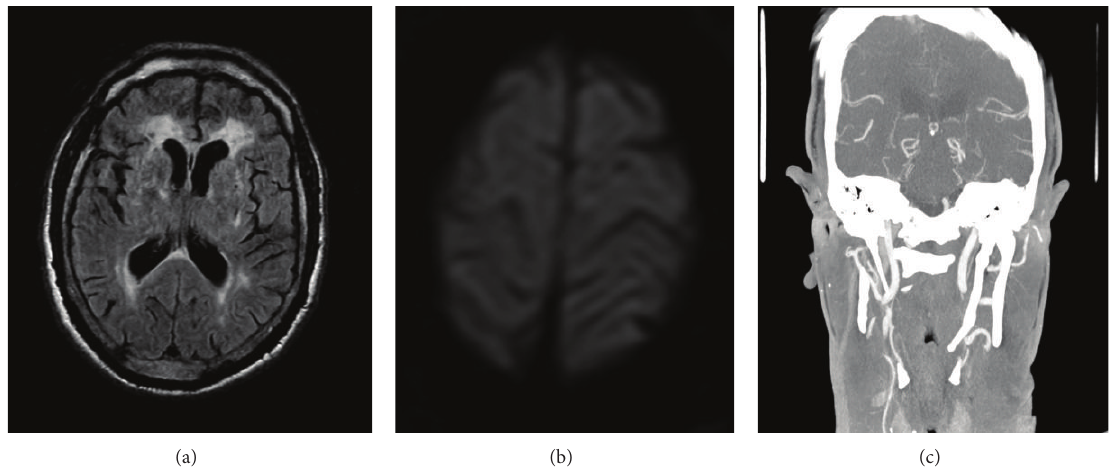
Figure 1: Pre-penicillin therapy imaging. (a) FLAIR, (b) DWI sequence, and (c) CT angiogram.